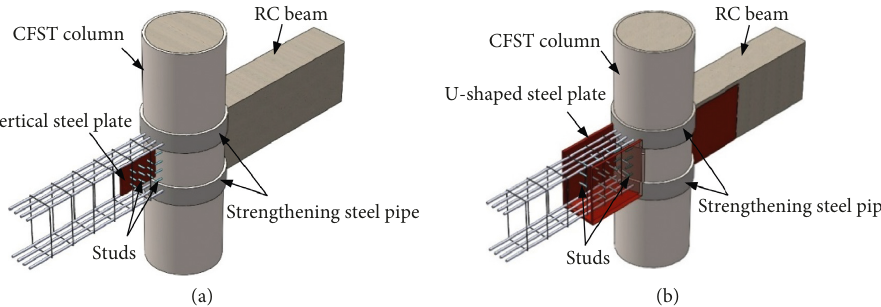
Figure 1: Schematic diagrams of the joints: (a) configuration of the steel plate-stud connection; (b) configuration of the U-shaped steel plate-stud connection.